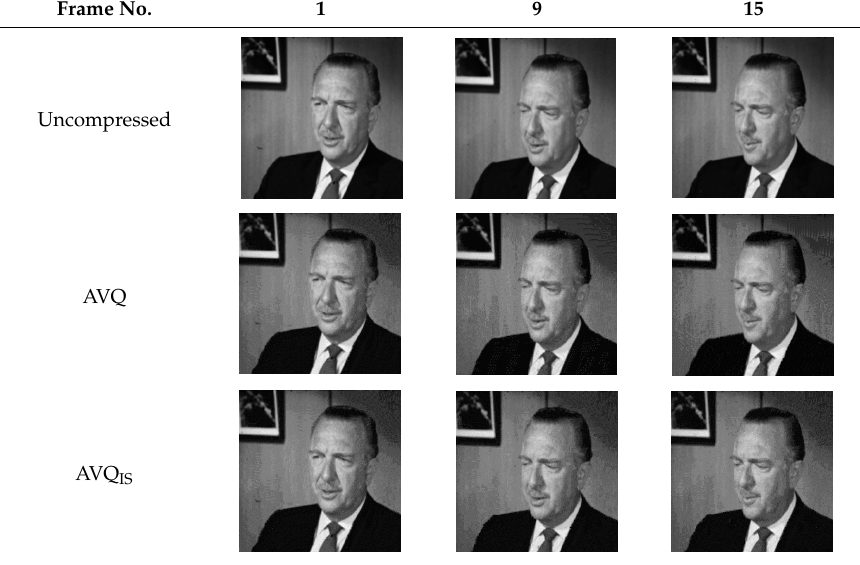
Table A1. Example of some frames from Seq. 1-Dataset 1. Appendix. Frame No.